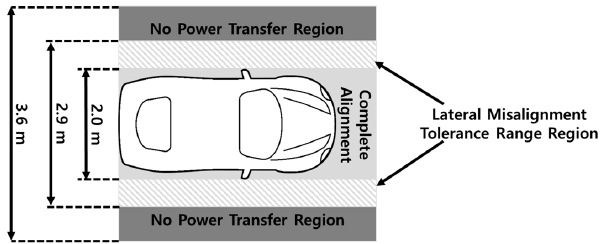
Figure 1. Power transfer coverage area on a 3.6 m width highway lane (based on FHWA standards [17]) for a WPT system with a 45 cm lateral misalignment tolerance. Equipped on a standard sized vehicle with a 2 m track width.